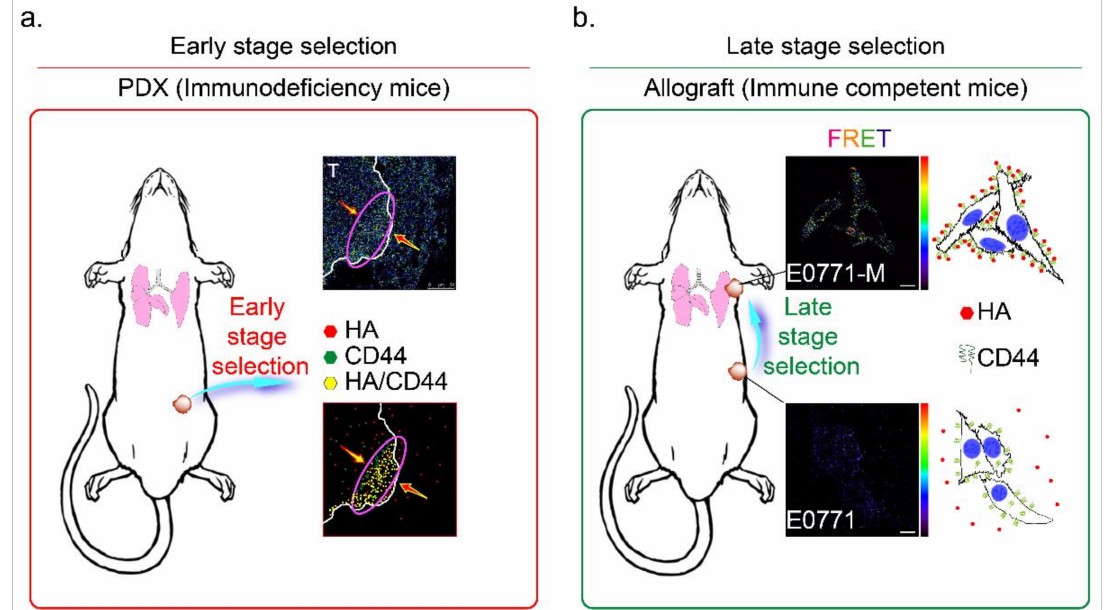
Figure 7. Mechanisms of HA and CD44 mediated selection of highly metastatic breast cancer cells. The metastatic tumor cells are subdivided into two populations, namely ( a ) early- and ( b ) late stage selected tumor cells. ( a ) In the early stage selection, the highly metastatic tumor cells were enriched and toward the tumor/normal stroma margin (red arrow). Highly malignant tumor cells with CD44 expression were determined by HA, which appears in the normal stroma in the early stage invasion (red oval circle); Magnification, 630 × ; scale bar, 50 µ m. ( b ) After the first step invasion, the cancer cells invaded into blood vessels, and step to the late stage selection, the HA content of the metastatic site (lung) selectively attracts the more motile E0771-M (CD44+) breast cancer cells. Magnification, 630 × ; scale bar, 10 µ